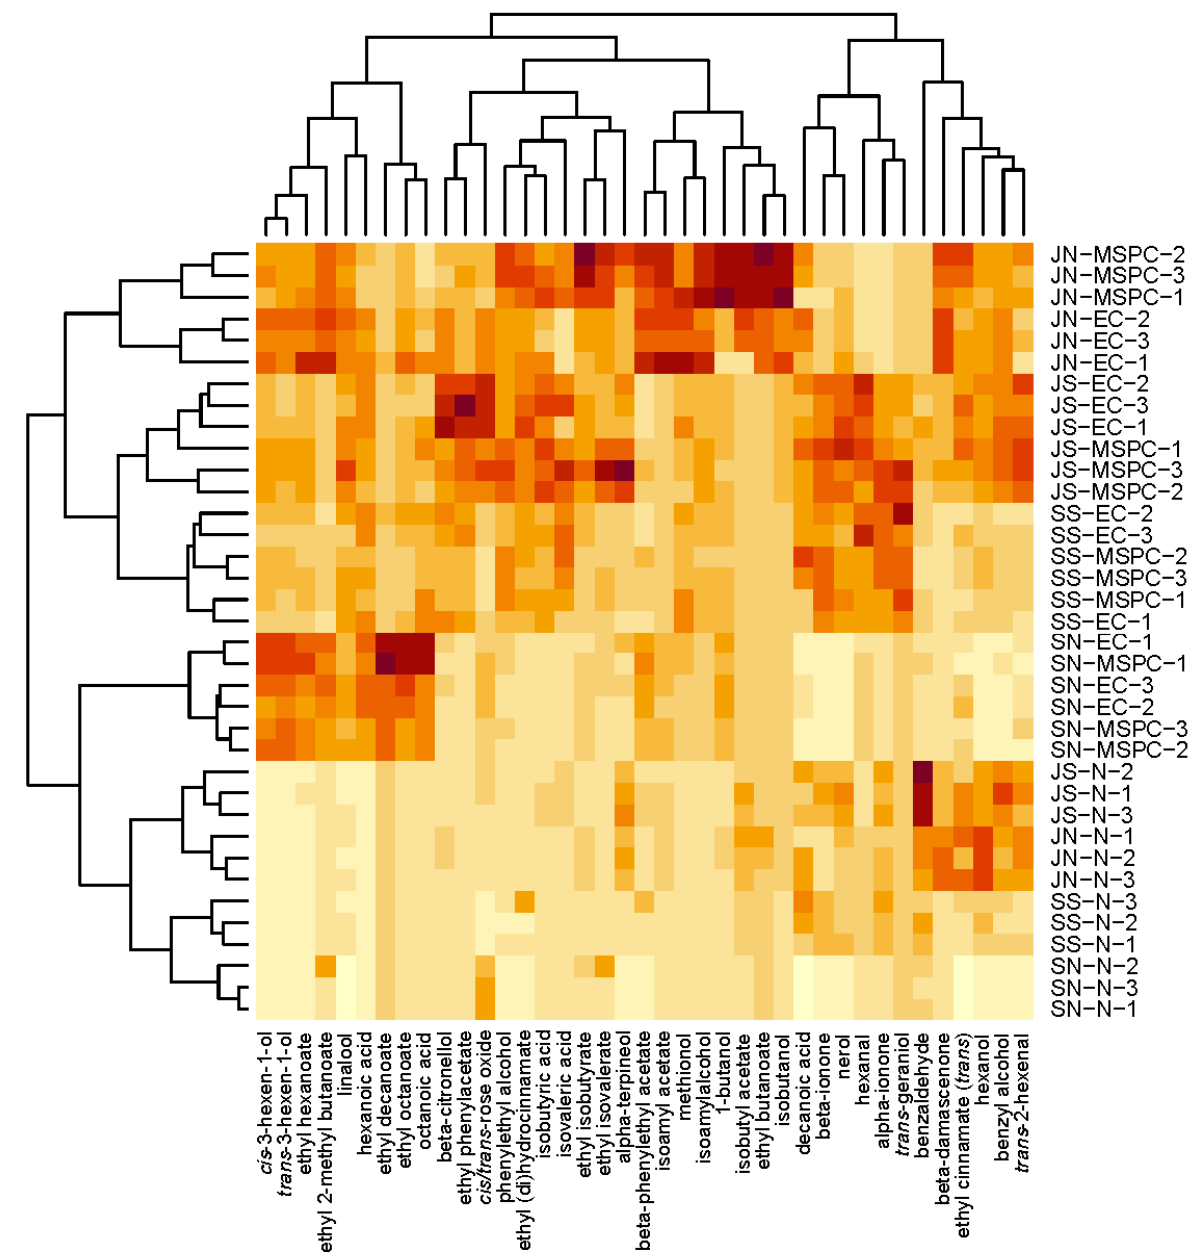
Figure 1. Heatmap and dendrogram to visualize clustering of the fermentation samples based on their volatile composition using 39 aroma compounds. The relative concentrations of each volatile are represented via a chromatic scale with the darkest red corresponding to the highest concentrations and the palest yellow corresponding to the lowest concentrations. Medium (JN, JS, SN, and SS) and inoculation treatments (EC, MSPC, and N).